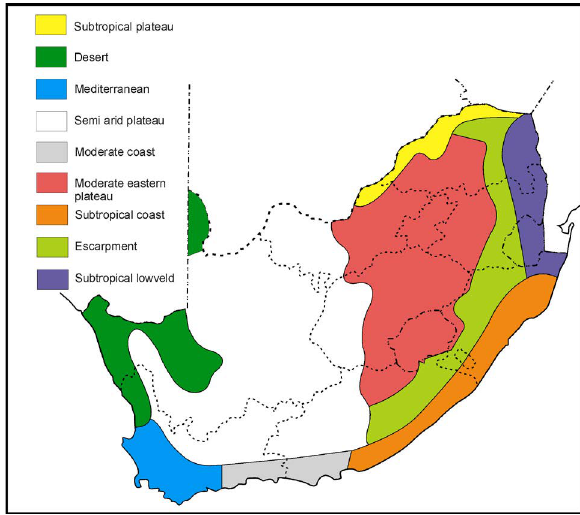
Figure 3: Climatic regions of South Africa 48 ; note the climatic variations along the